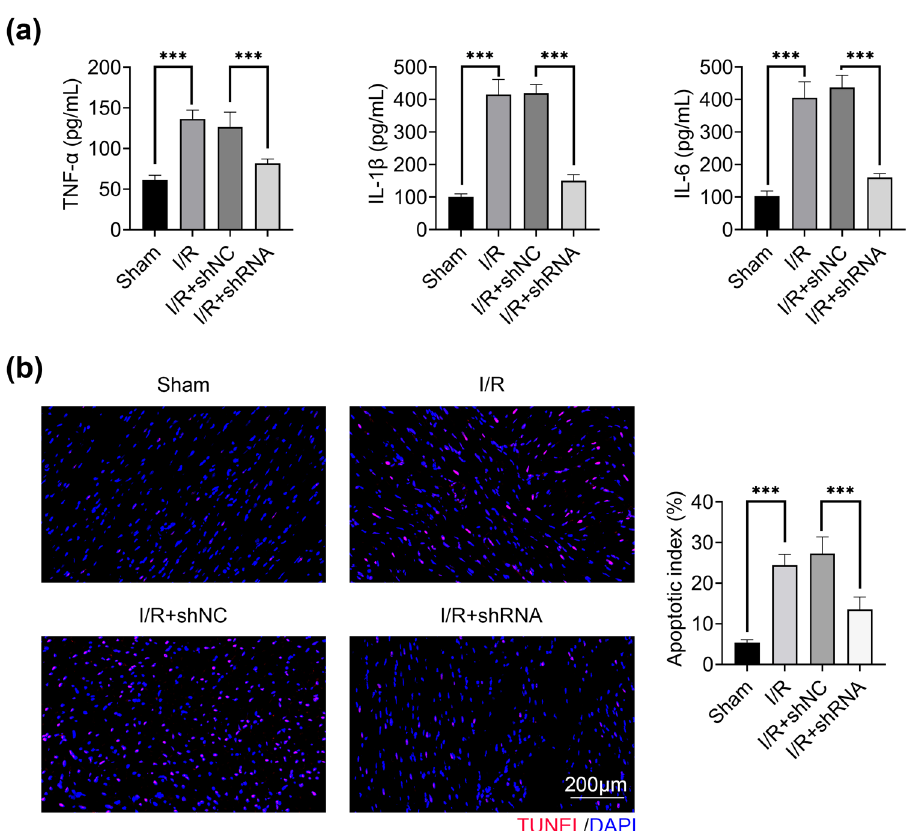
Figure 2: Knockdown of HAGLR prevented in fl ammation and cell apoptosis induced by I/R. ( a ) The levels of TNF - α , IL - 1 β and IL - 6 in blood in I/R and I/R + shRNA groups were assessed by ELISA. *** p < 0.001. Data were expressed as mean ± SD of three independent experiments. ( b ) TUNEL and DAPI staining were used to detect cell apoptosis. Left : representative photos of myocardial tissue stained by TUNEL and DAPI staining. Right : apoptotic index of myocardial tissue of I/R and I/R + shRNA groups. *** p < 0.001. Data were expressed as mean ± SD of three independent